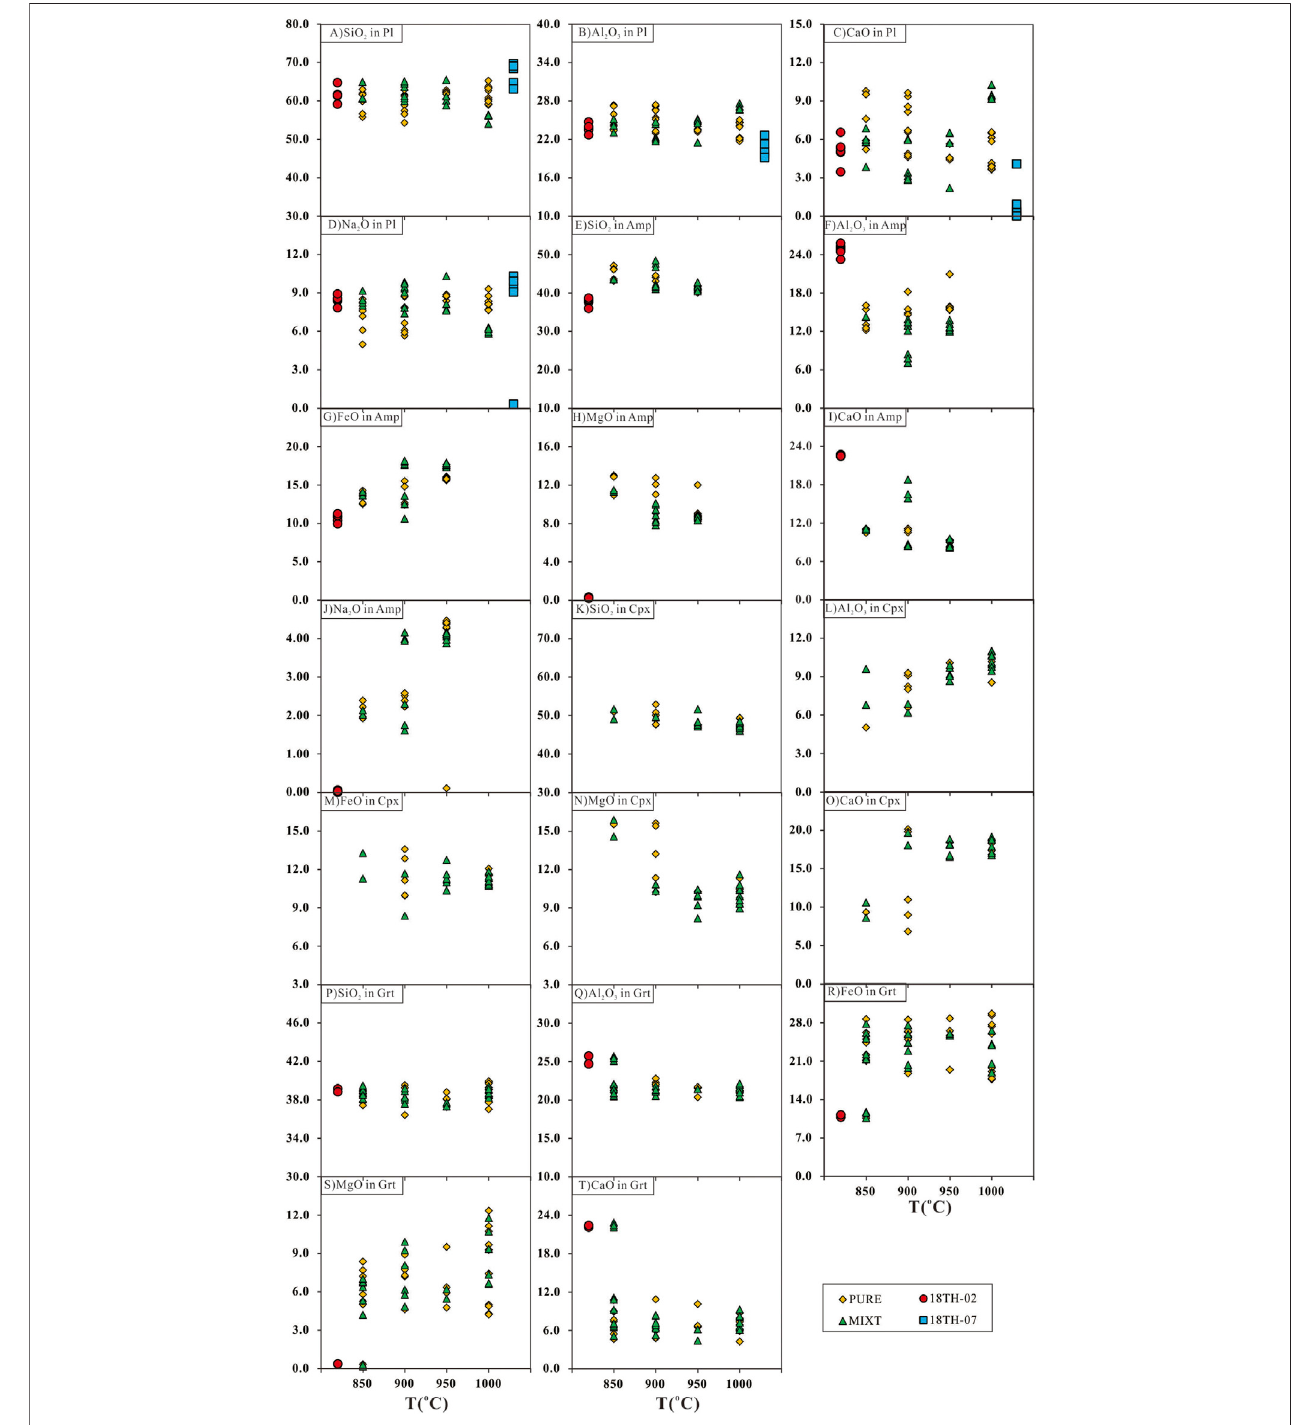
FIGURE 7 | Plots of major-element oxide concentrations in plagioclase (A-D) , amphibole (E-J) , clinopyroxene (K-O) , and garnet (P-T) . These minerals are from starting materials (18TH-02 and 18TH-07) run products from PURE and MITX.